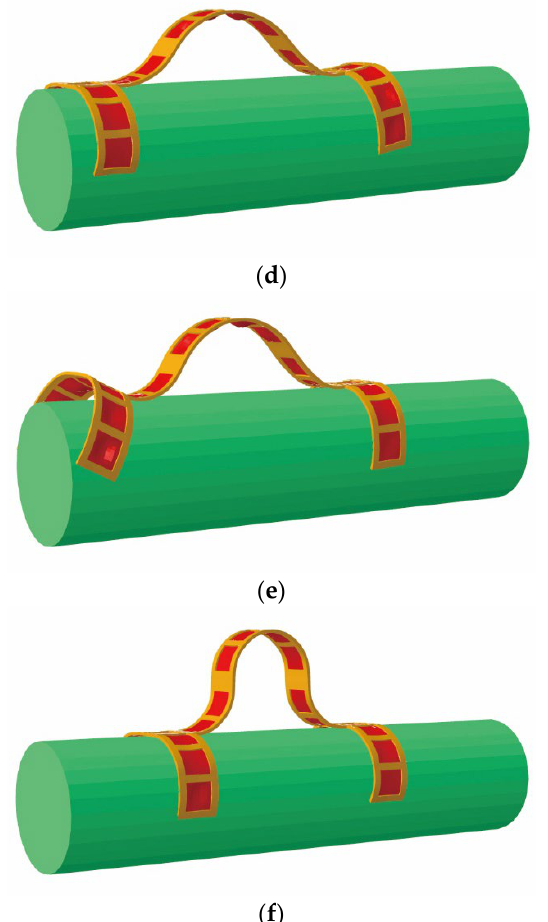
Figure 1. Design and simulated locomotion of an inchworm-inspired soft machine climbing a rod. ( a ) Planar view and dimensions (in millimeters) of the designed climber consisting of the anterior leg, hind leg, and central body. The central body has six segments of DEMES units and both the anterior and hind legs have seven units, with a red color DE membrane and yellow color frame. ( b – f ) A series of looping motions of the DEMES climber climbing a rod.